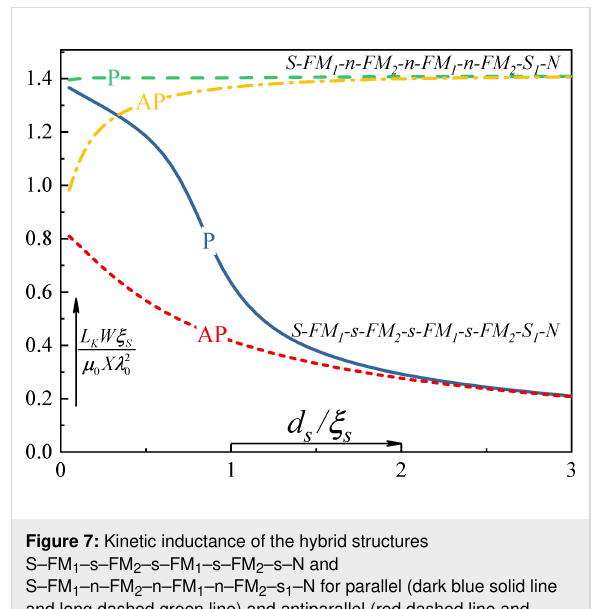
Figure 7: Kinetic inductance of the hybrid structures S–FM 1 –s–FM 2 –s–FM 1 –s–FM 2 –s–N and S–FM 1 –n–FM 2 –n–FM 1 –n–FM 2 –s 1 –N for parallel (dark blue solid line and long dashed green line) and antiparallel (red dashed line and orange dash–dot line) mutual orientations of magnetization between FM 1 and FM 2 layers as functions of the spacer